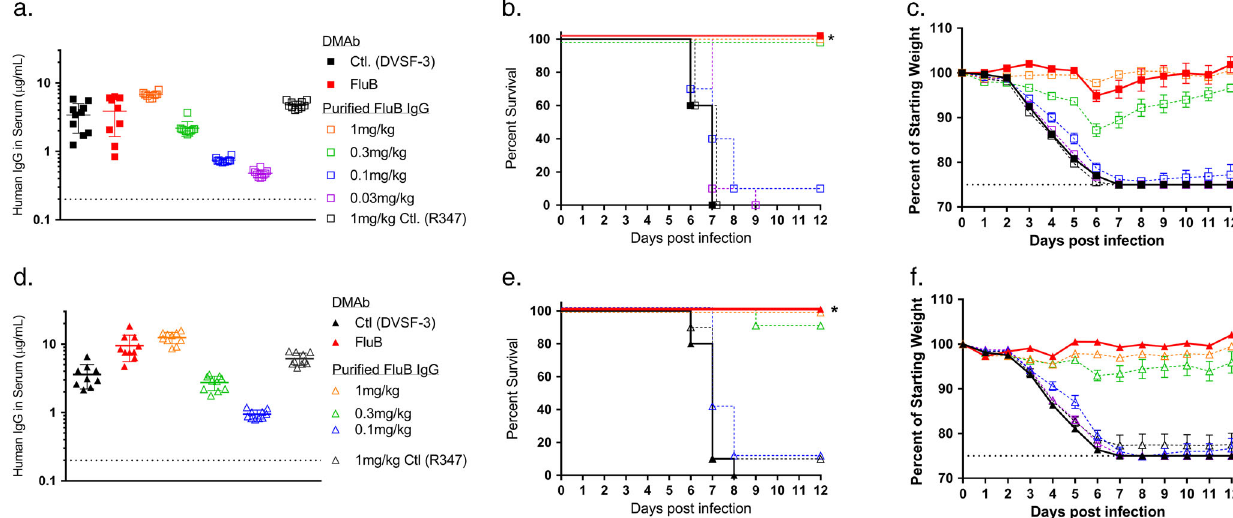
Fig. 4 FluB DMAb protects mice from diverse lethal in fl uenza B challenges. BALB/c mice were treated with FluB DMAb plasmid DNA 5 days prior to infection with B/Malaysia/2506/2004 Victoria ( a – c ) or B/Florida/4/2006 Yamagata ( d – f ) lineage virus. One day prior to infection, separate groups of mice received 0.03 – 1 mg/kg FluB protein monoclonal antibody i.p. a , d Human IgG in mouse sera at the time of infection. Dotted line indicates LOD ( n = 10 animals per group, mean ± SD). b , e Kaplan – Meier survival curves of BALB/c mice challenged with in fl uenza B ( n = 10 animals per group, * p ≤ 0.0001 FluB DMAb versus Control DMAb). c , f Weight of BALB/c mice following in fl uenza B challenge. Dotted line indicates 25% maximum weight loss. ( n = 10 animals per group, mean ±